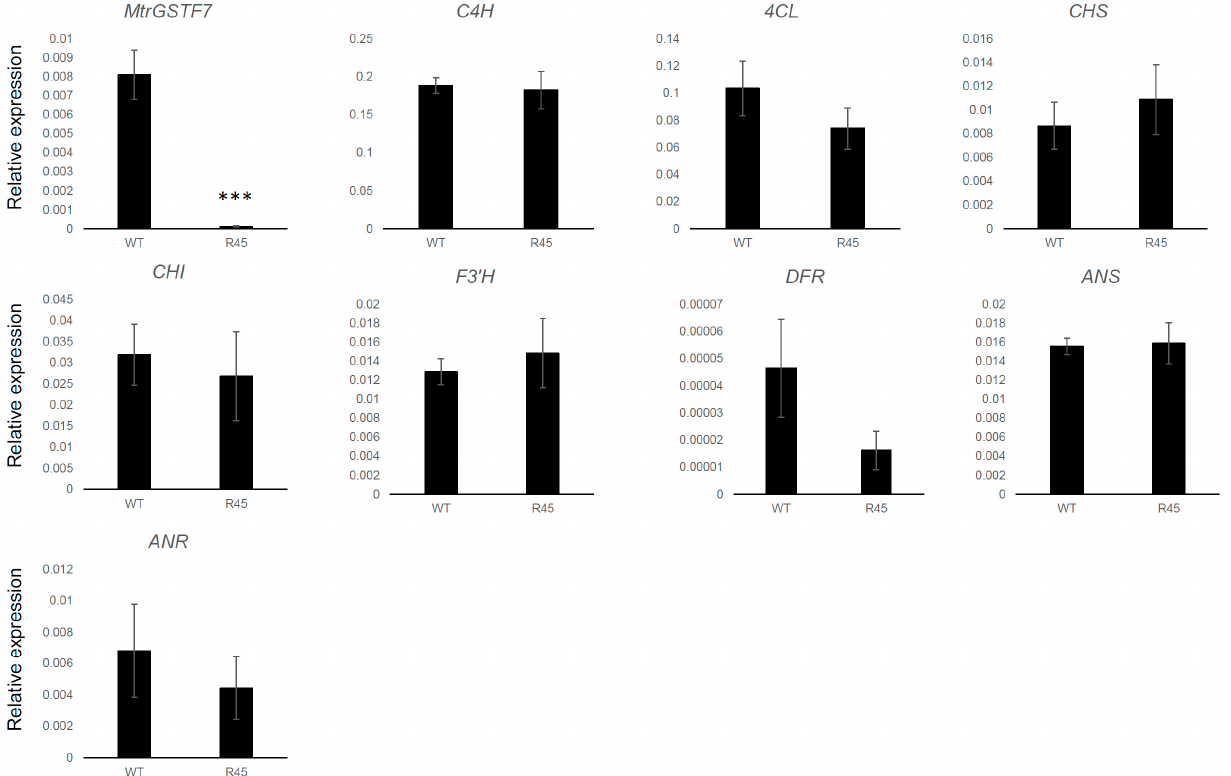
Figure 9. Expression levels of key genes of the phenylpropanoid pathway in M. truncatula leaves of wild-type R108 (WT) and mutant plants (R45) grown under controlled conditions. The relative expression of each gene is calculated using the [2 − ( ∆ Ct) ] algorithm using actin as housekeeping gene. Significance of differences between means was determined by t -test (*** p < 0.001).